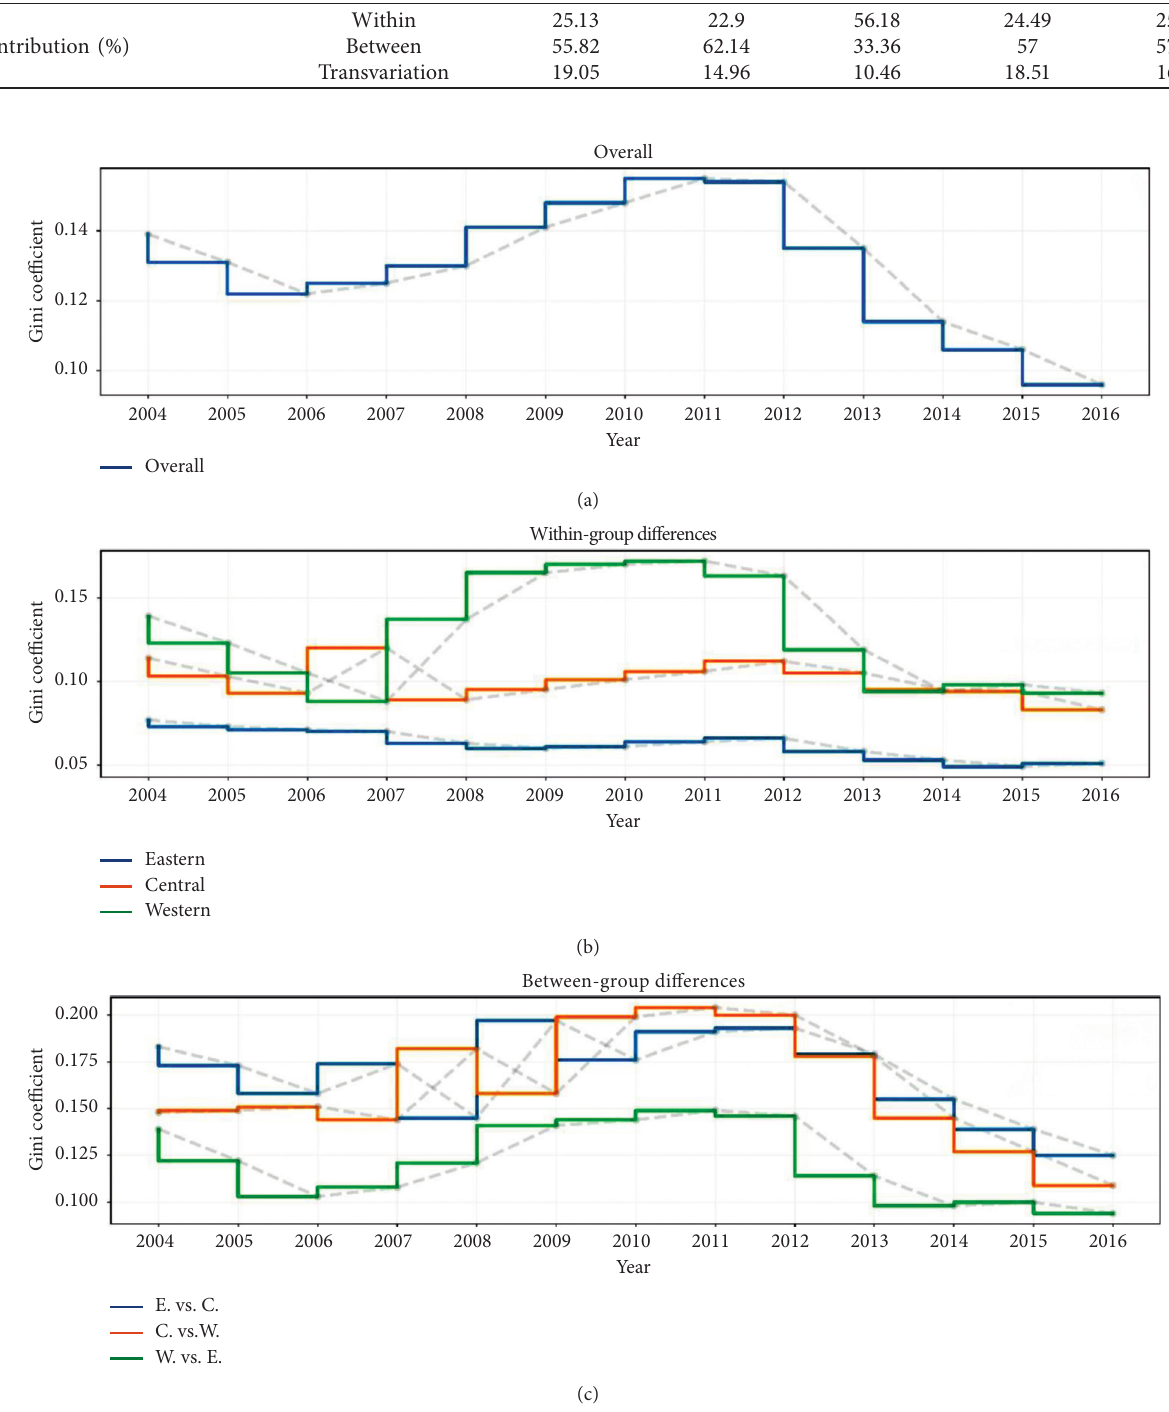
Figure 3: Gini coefficient and decomposition of urban construction land utilization